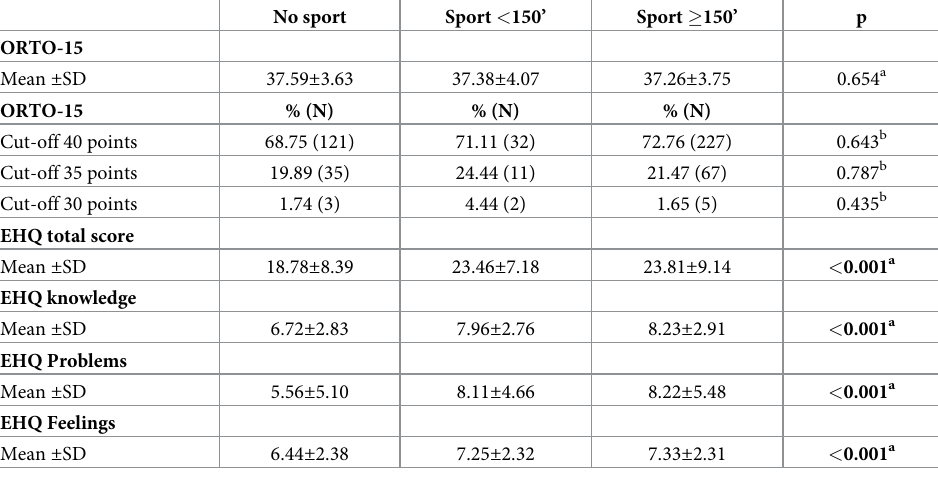
Table 3. Sample mean ORTO-15 and Eating Habit Questionnaire scores, based on sport activity during the